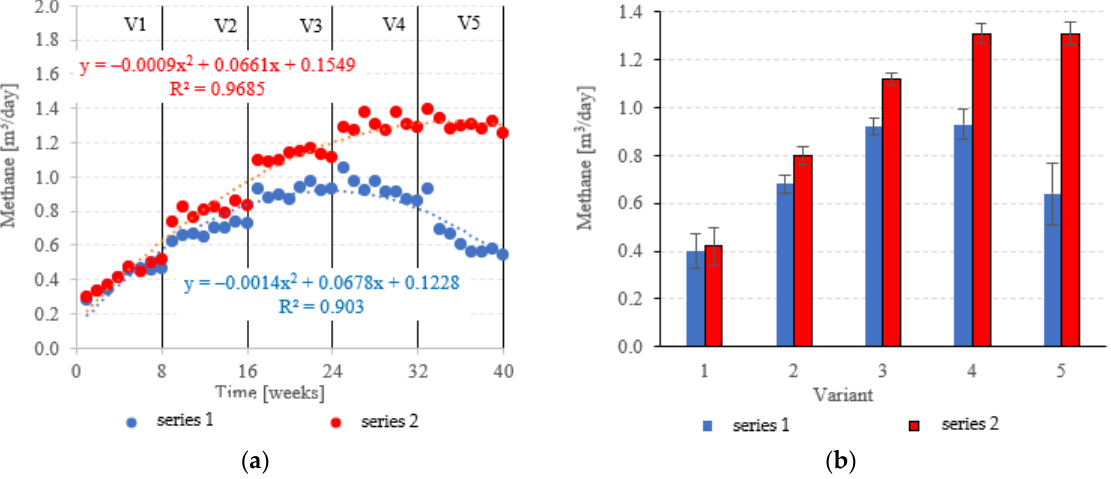
Figure 17. CH 4 yields (( a ) daily throughout the experiment; ( b ) average daily across experimental variants). Table 4. CH4 production efficiency in relation to the COD